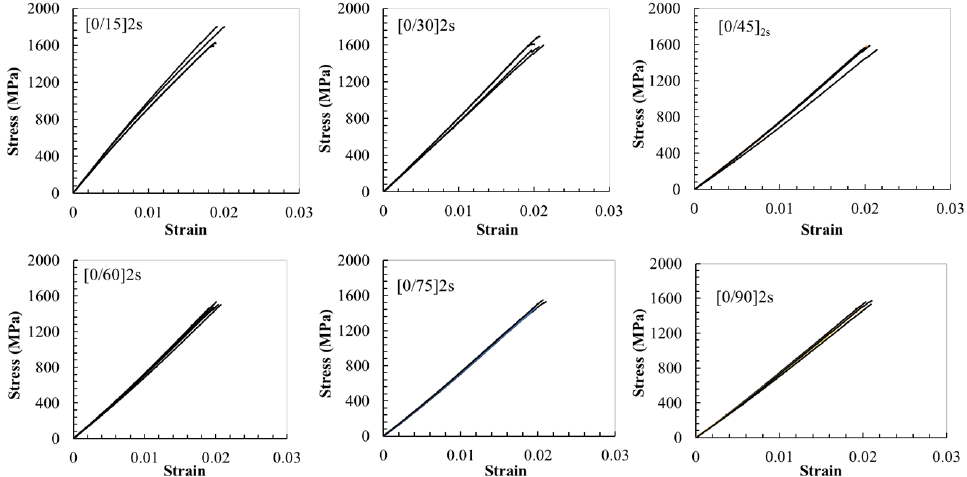
Figure 2. Stress–strain responses of various [0/ θ ] 2s laminates, and different lines in each subfigure represent different specimens of each [0/ θ ] 2s laminate.